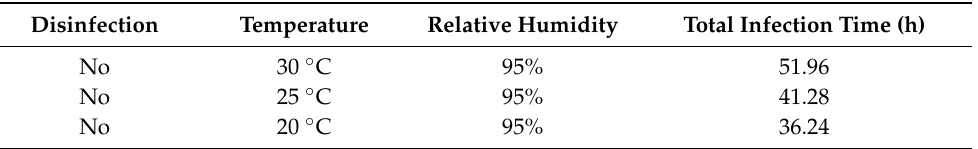
Table 2. Effect of temperature and disinfection on virus transmission in express boxes (If the number of infections is <10, it is denoted by